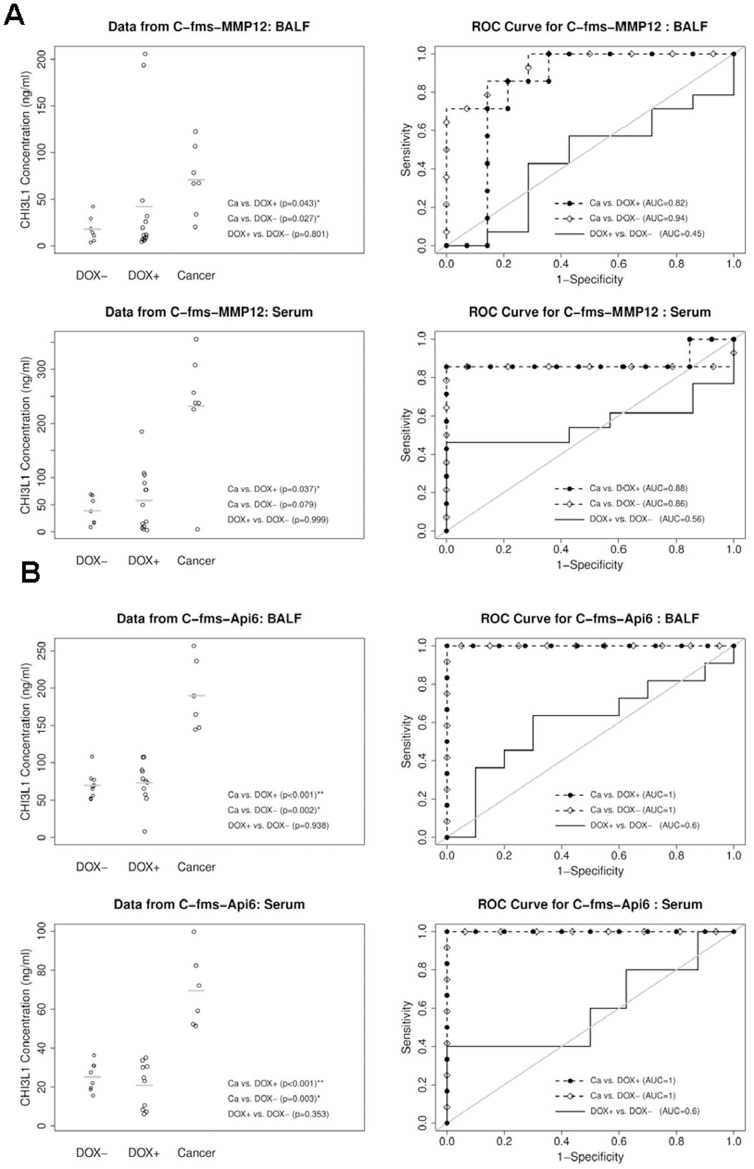
ELISA analyses of CHI3L1 protein in BALF and serum of systemic inflammation-induced lung tumor mice.Left: CHI3L1 protein concentrations in BALF and serum of doxycycline-treated and untreated bitransgenic mice. Right: ROC (Receiver Operating Characteristic) curve analyses to determine the area under the curve (AUC). Dox-: doxycycline-untreated mice; Dox+: doxycycline-treated mice without showing lung tumor; Cancer, doxycycline-treated mice with lung tumor. A) c-fms-rtTA/(TetO)7-CMV-MMP12 mice. Mean ± SD in BALF (n>7), DOX -: 17.7±13.8, DOX +: 42.1±67.9, Cancer: 70.9±36.5. Mean ± SD in serum (n>7), DOX -: 39.1±25.6, DOX +: 57.7±55.5, Cancer: 232.3±110.6. The gray lines represent the mean values; B) c-fms-rtTA/(TetO)7-CMV-Api6 mice. Mean ± SD in BALF (n>6), DOX -: 69.6±16.6, DOX +: 73.2±28.1, Cancer: 189.9±47.2. Mean ± SD in serum (n>6), DOX -: 25.2±7.3, DOX +: 21.0±11.7, Cancer: 69.5±19.1. The gray lines represent the mean values.